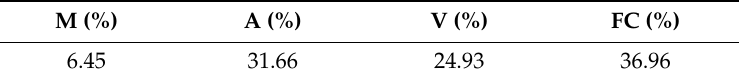
Table 1. Basic analysis of coal sample (Air